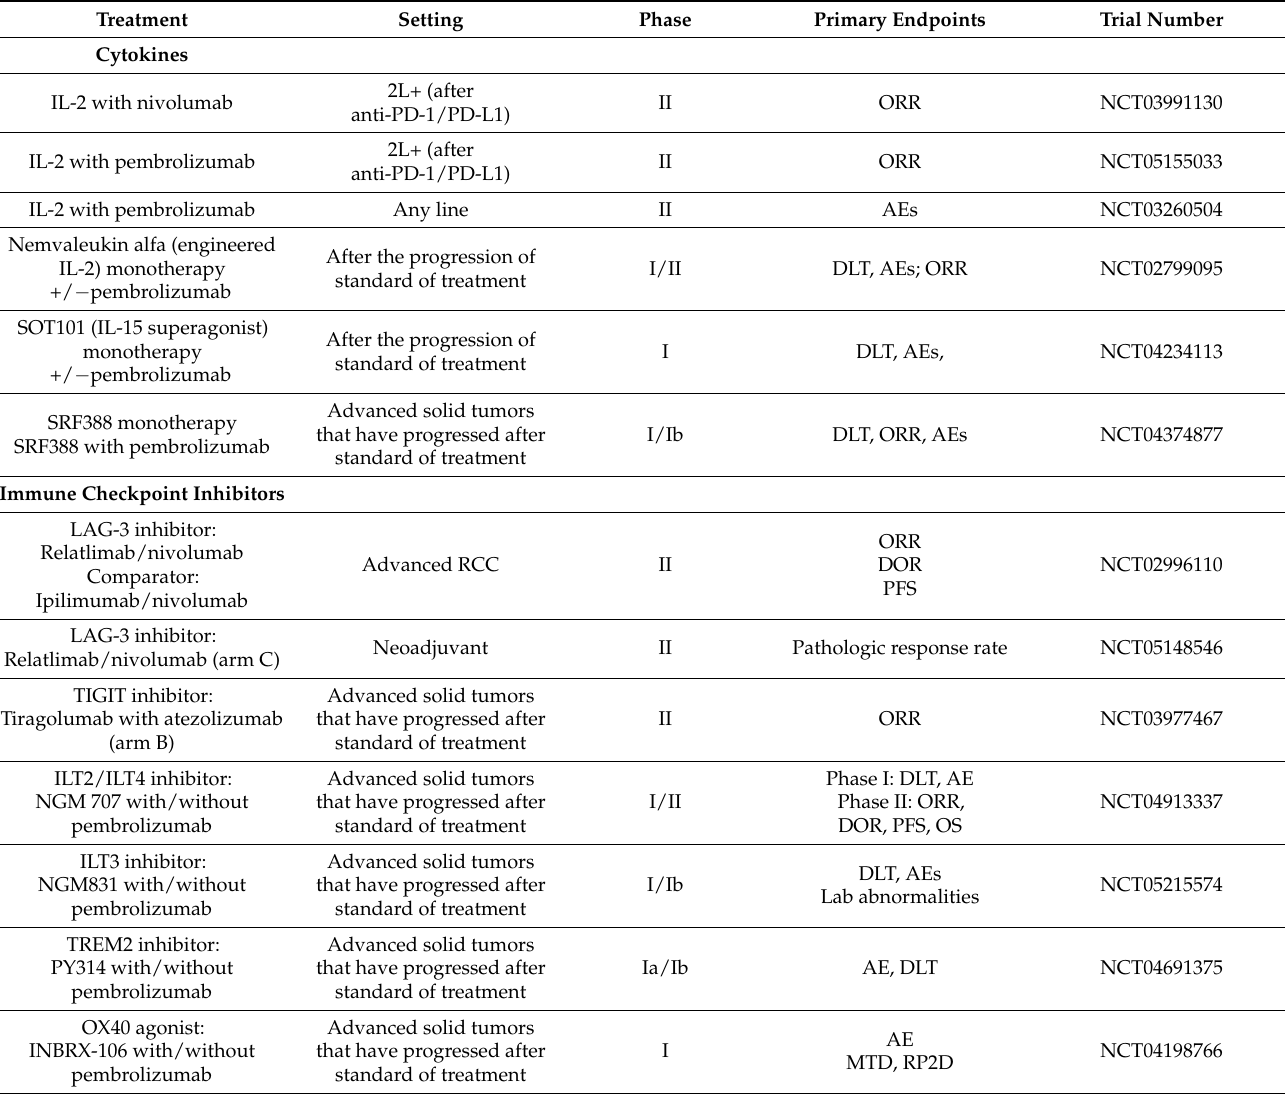
Table 2. Ongoing clinical trials targeting cytokines and new immune